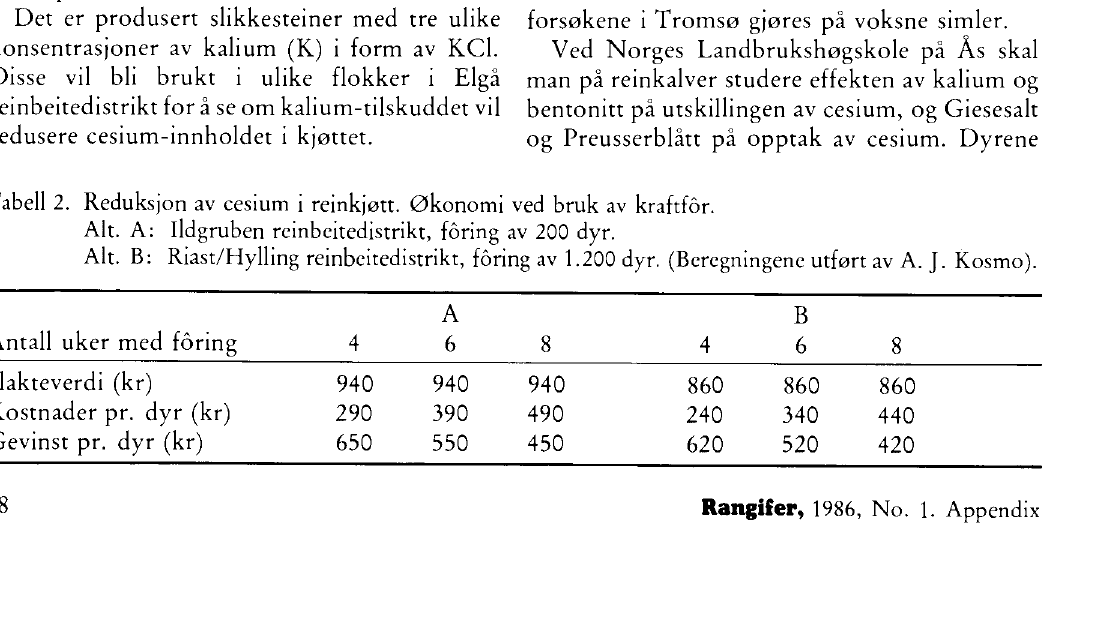
Tabell 2. Reduksjon av cesium i reinkjøtt. Økonomi ved bruk av kraftfor. Alt. A: Ildgruben reinbeitedistrikt, foring av 200